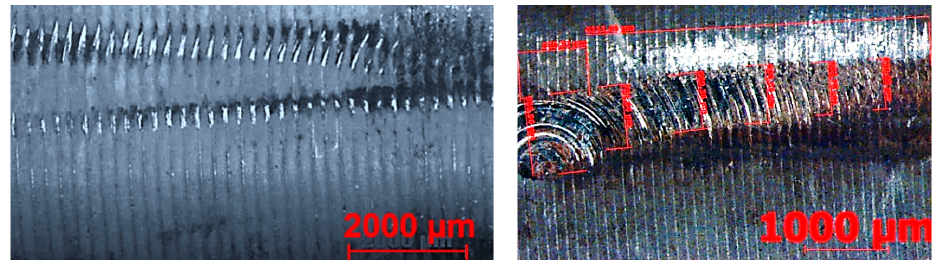
Figure 17. Sample No. 11—20 × magnification, 1.8 × 103 cycles of 5 N load ( left ); Sample No. 55—10 × magnification, 5 × 103 cycles, 5 N load ( right ).